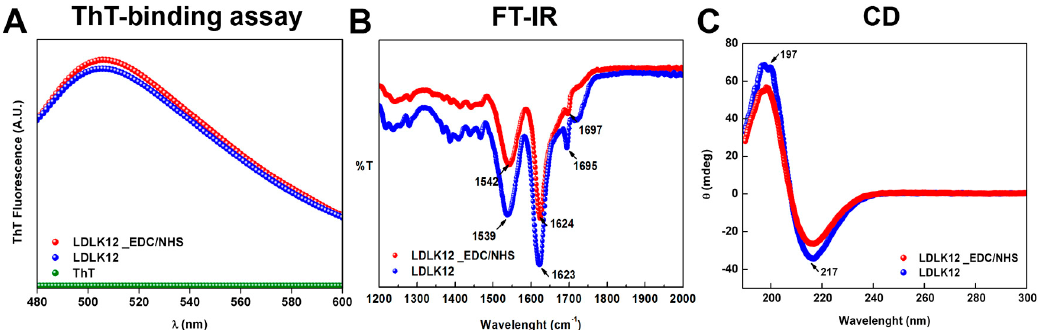
Figure 3. Supramolecular organizations of assembled peptide nanostructures. ( A ) Thioflavin-T (ThT)-binding assay of LDLK12 hydrogels showing typical amyloid-binding emission signal (centered at ∼ 500 nm); no signal was observed for ThT alone. ( B ) FT-IR spectra of the wildtype and cross-linked LDLK12 peptides with characteristic β -sheet peaks. ( C ) Circular dichroism (CD) spectra of both self-assembling peptides (SAPs) with and without EDC / sulfo–NHS cross-linking suggesting the presence of β-sheet secondary structures.